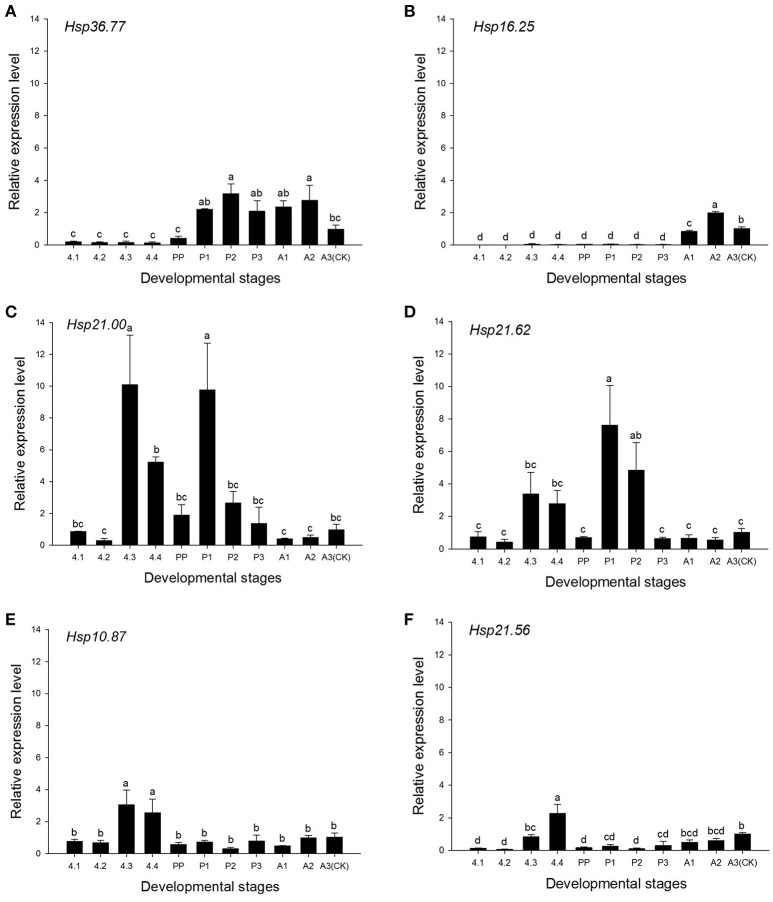
Relative expression levels of several sHSPs in Harmonia axyridis in different development stages. Experimental population is used for this trial. (A)
Hsp36.77. (B)
Hsp16.25. (C)
Hsp21.00. (D)
Hsp21.62. (E)
Hsp10.87. (F)
Hsp21.56.Changes in H. axyridis sHSPs mRNA levels from day 1 of fourth-instar larvae to adult stage in relation to those of Harp49 (H. axyridis ribosomal protein 49 gene) were measured by quantitative real-time PCR. 4, fourth-instar larva; PP, pre-pupae; P, pupae; and A, adult. Each combination of letters and numbers represents the age of the individual at a certain developmental stage (e.g., 4.1: the 1st day of fourth-instar larva). Data are presented as means ± s.d. (n = 3). Bars with different letters indicate significant differences (P < 0.05) and used Tukey's test, α = 0.05, a > b > c.